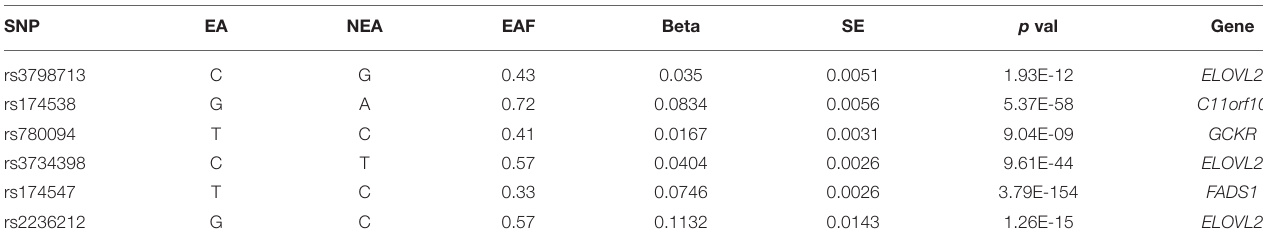
TABLE 1 | Six plasma omega-3 genetic instrumental variants.